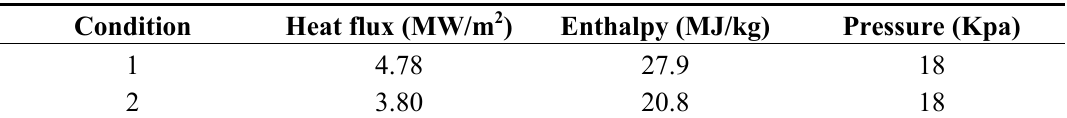
Table 1. Testing